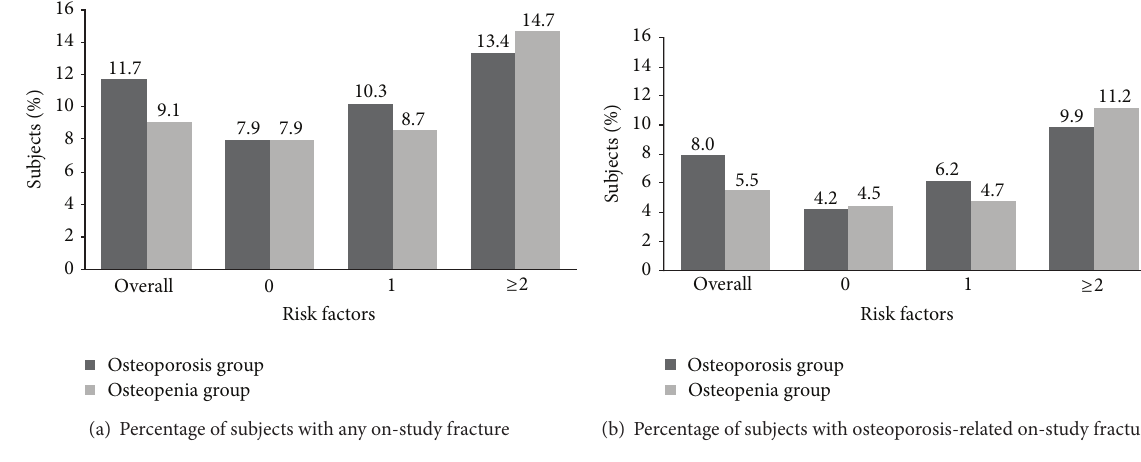
Figure 3: Percentage of subjects reporting on-study fracture stratified by number of fracture risk factors. Table 2: Subject-reported on-study osteoporosis-related fracture stratified by number of risk factors. Subjects with 0 risk factors Subjects with 1 risk